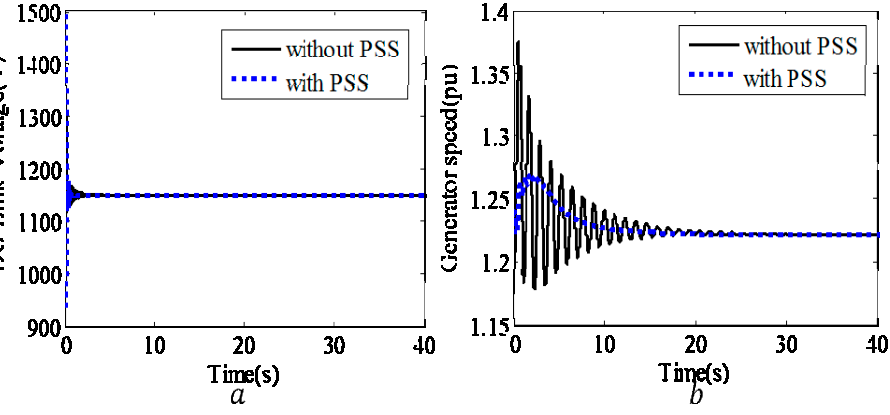
Figure 17. ( a ) DC-link voltage and ( b ) generator speed with Figure 17 . ( a ) DC ‐ link voltage and ( b ) generator speed with PSS.